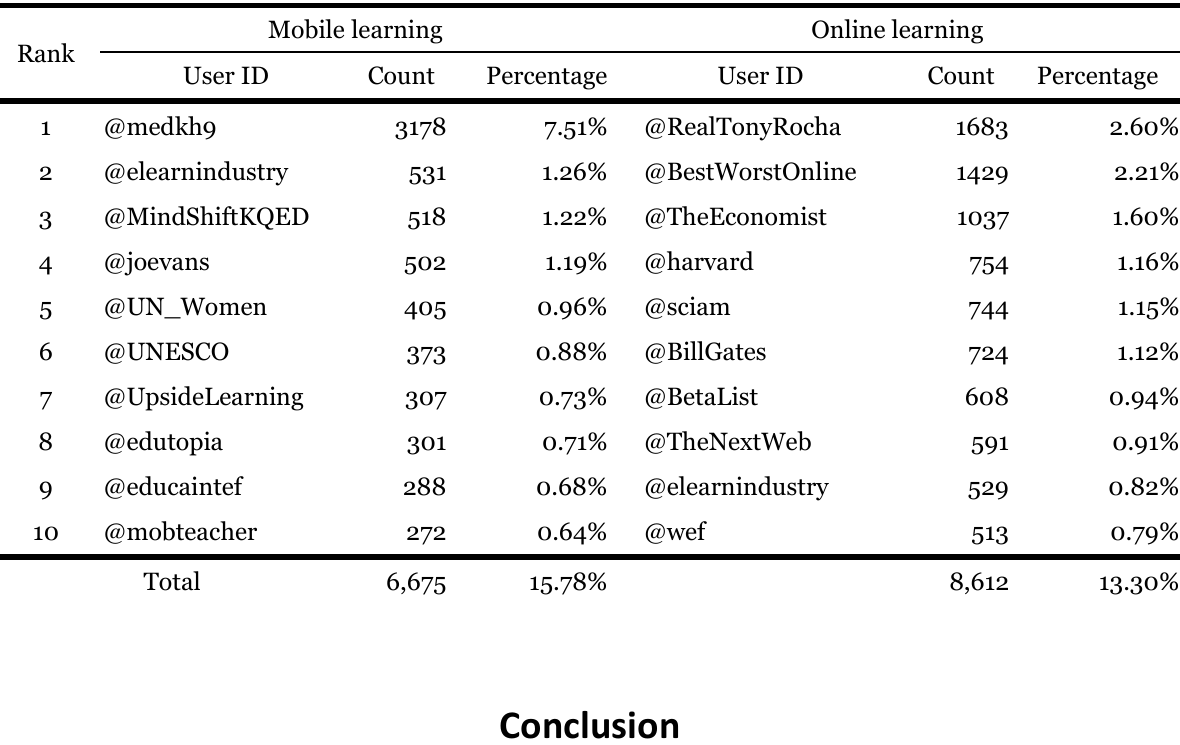
Top 10 Users by the Number of